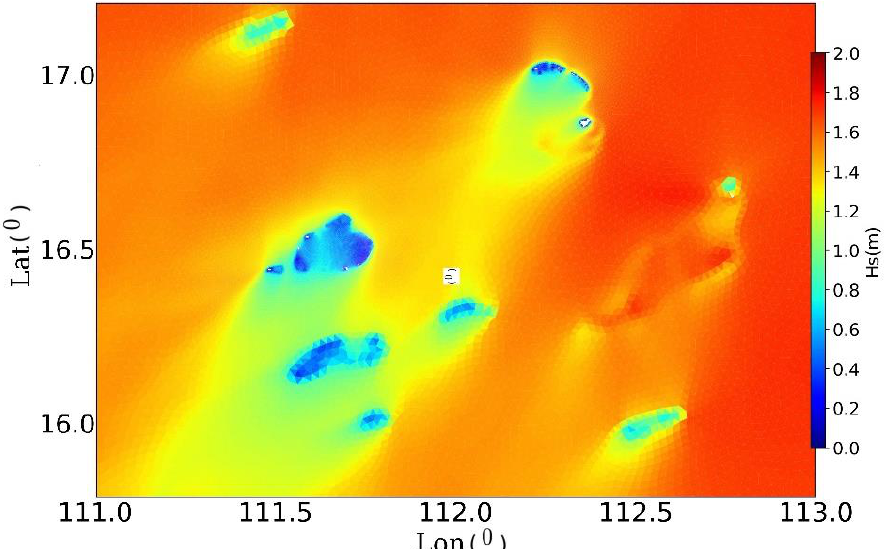
Figure 8. Distribution of the annual mean H s in the Xisha Islands.